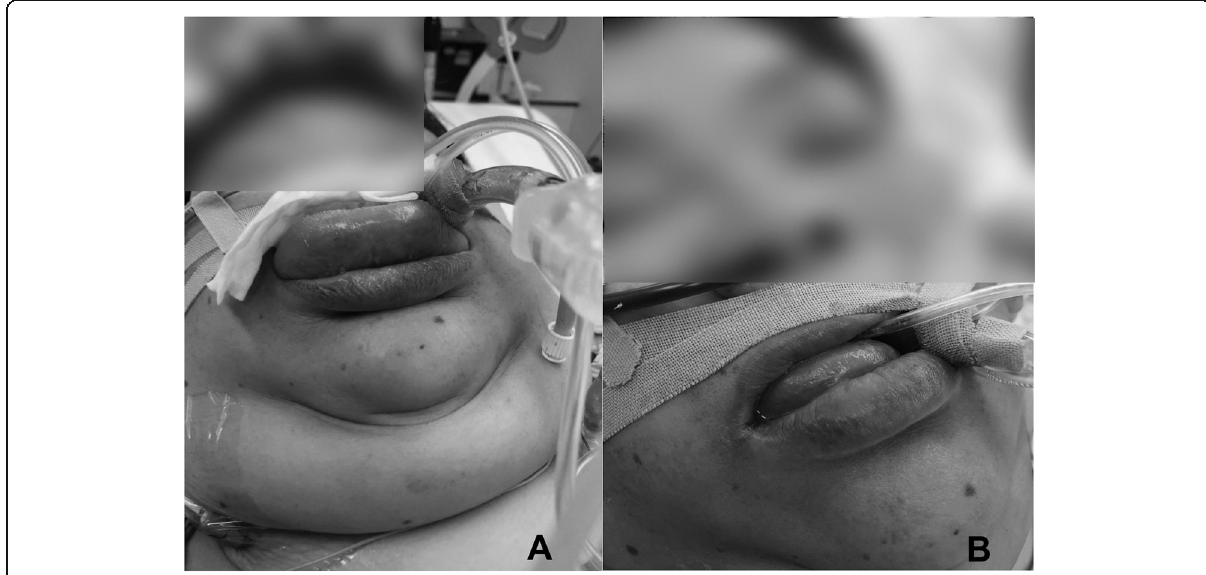
Fig. 1 a The swollen tongue was protruding from the oral cavity after reintubation in the intensive care unit after surgery. b The massive tongue swelling was improved gradually on the next